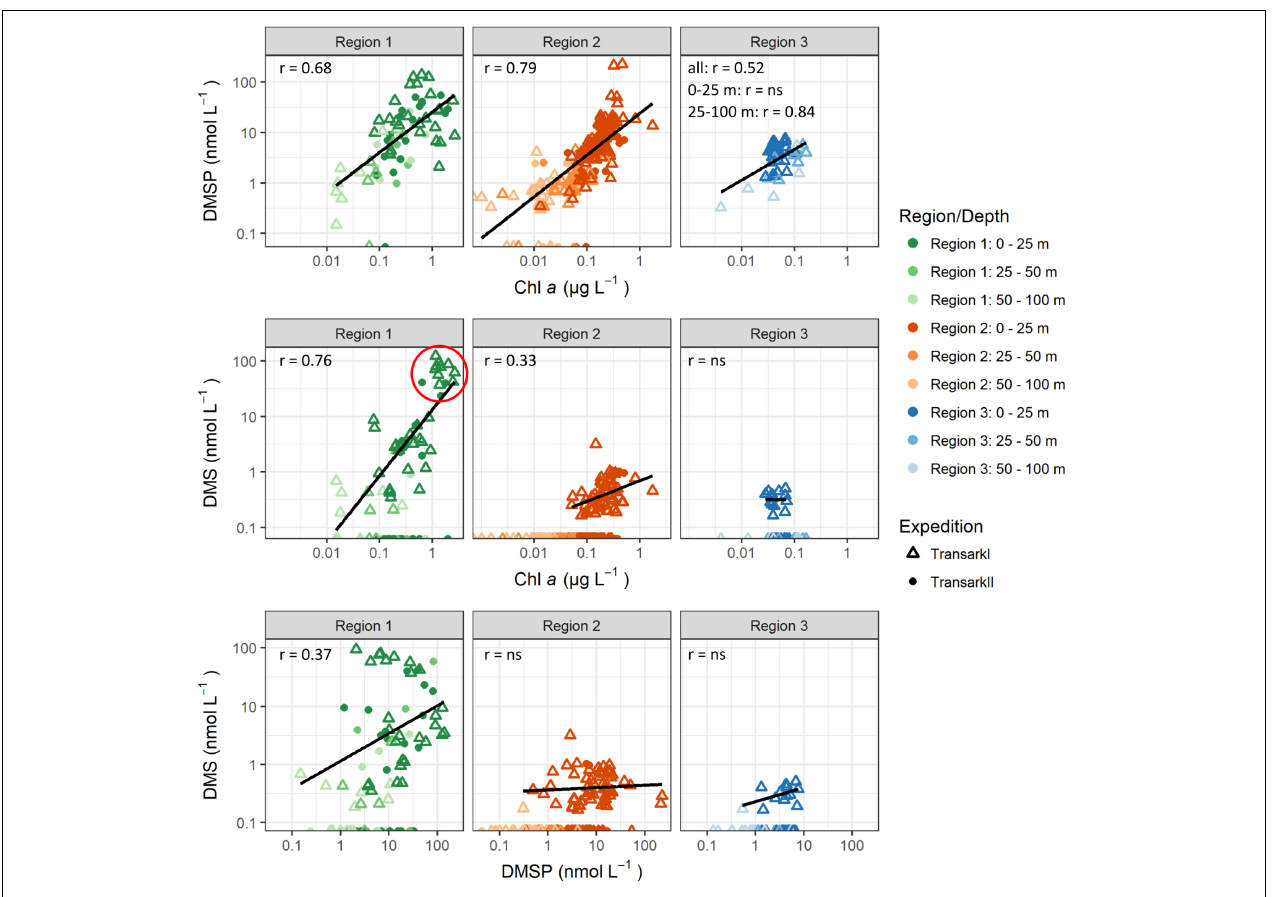
FIGURE 4 | Correlations between DMSP and DMS to chlorophyll a and DMS to DMSP. DMS and DMSP values < LOQ are shown at the x -axis. Correlations were calculated with DMS and DMSP values > LOQ. Outliers were omitted for correlations: Region 2 DMSP > 200 nmol L − 1 , DMS > 2 nmol L − 1 . Pearson correlation coefficients (r) are shown for p -value < 0.05. For p -value > 0.05 “ns” indicates that those were not statistically significant. Stations with high DMS concentration in Region 1 (red circle) are PS78/203 ( n = 10, depth < 11 m), PS94/34 ( n = 2, depth: 20 m, 28 m), and PS94/54 ( n = 2, depth: 2 m, 10